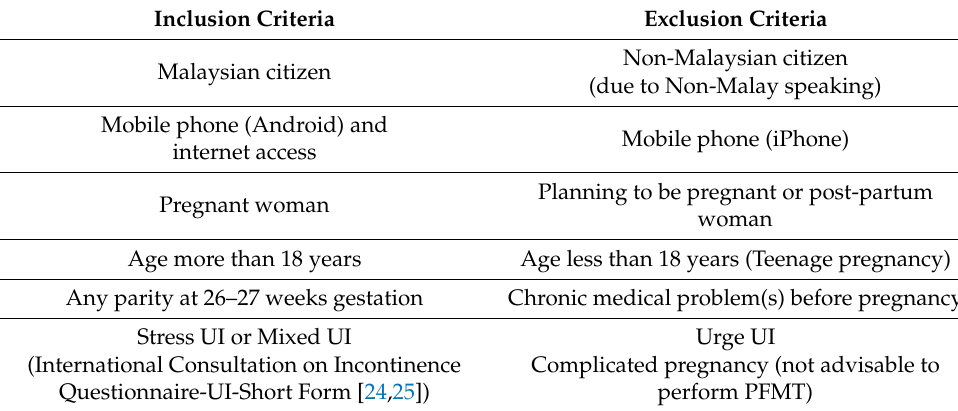
Table 1. Participant inclusion and exclusion